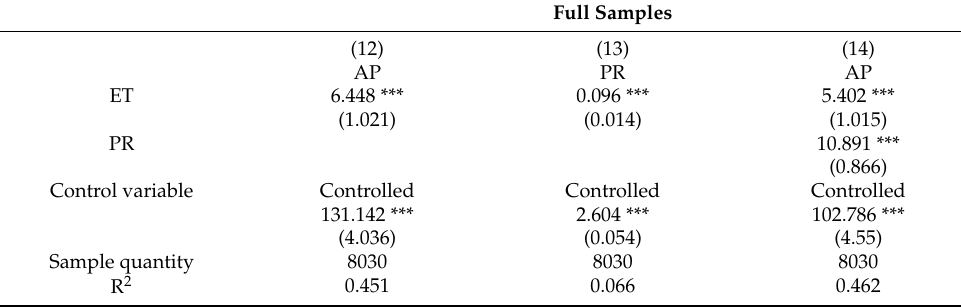
Table 7. Psychological resilience mediation effect (ET and